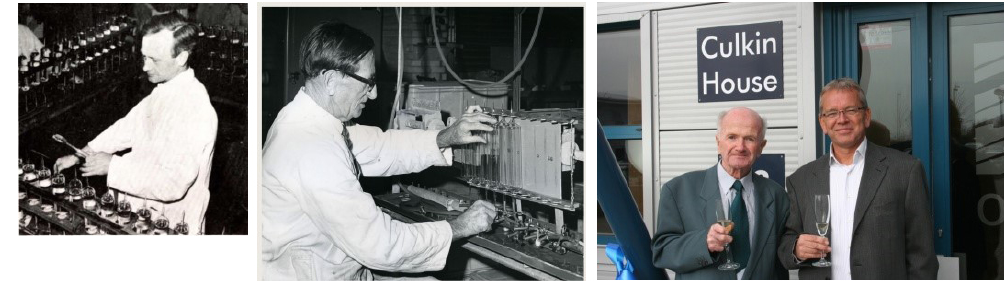
Figure 8. From the early days of Frede Hermann, through IOS to OSIL (source: UK National Oceanography Archives and OSIL).